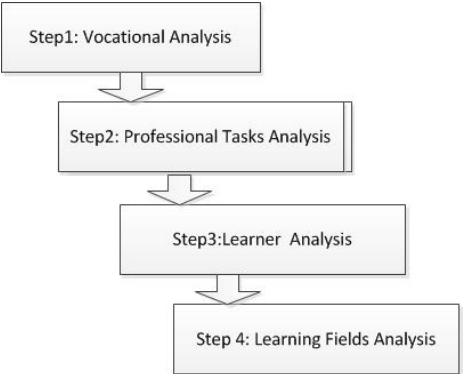
Figure 1. Proposed framework of the professional-task-based curriculum